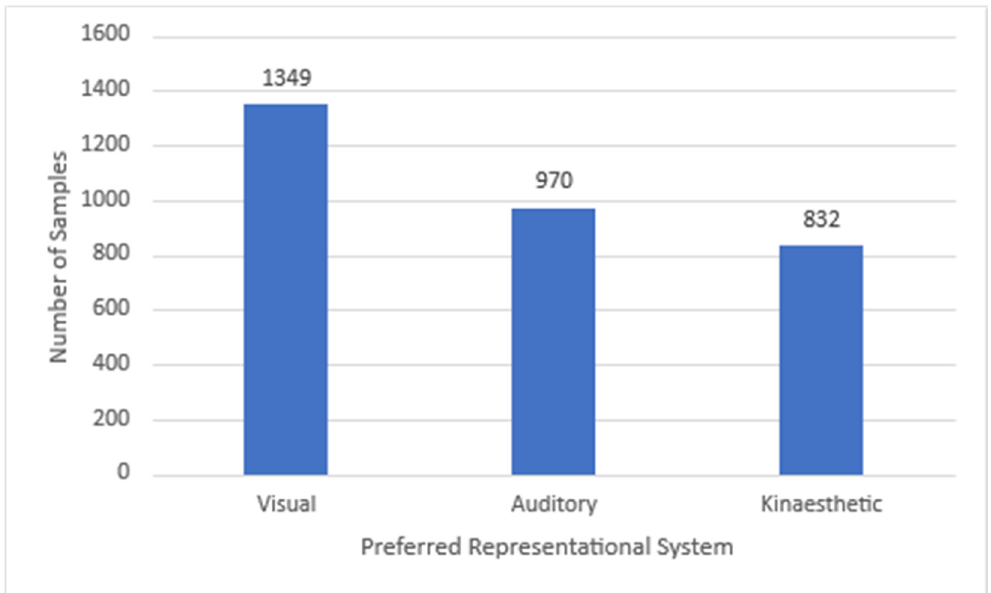
Figure 1. Number of samples for the Visual, Auditory, and Kinaesthetic labels.